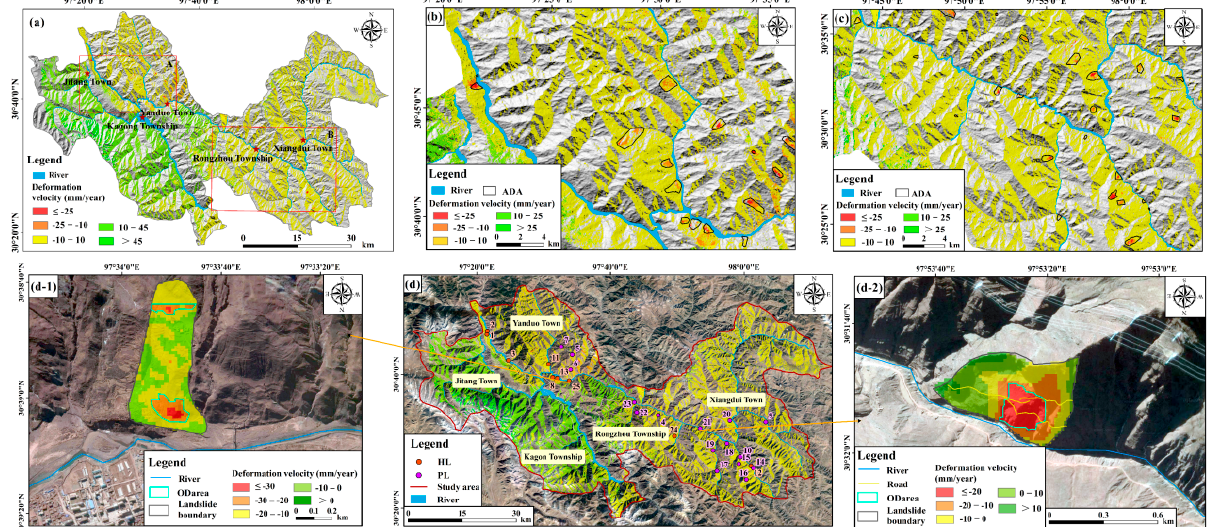
Figure 5. Recognition of active landslides. ( a ) Deformation velocity in the good visibility and low sensitivity regions. ( b ) Active deformation areas in Sub-region A. ( c ) Active deformation areas in Sub-region B. ( d ) 25 identified active landslides including active historical landslides and active potential landslides. ( d-1 ) Deformation characteristics of the active landslide AL-25. ( d-2 ) Deformation features of the newly discovered landslide AL-21. The base images are Mapbox images. The abbreviations include: ADA = Active deformation area; HL = Historical landslide; PL = Potential landslide; and ODarea = Obvious deformation area.